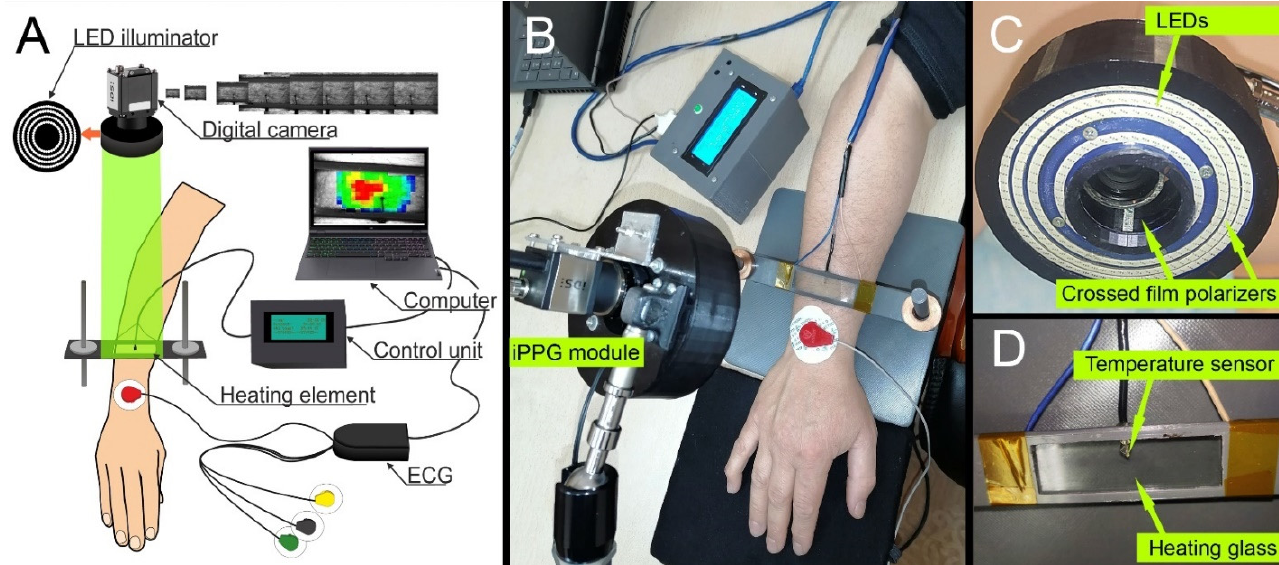
Figure 1. Schematic and photograph of the multimodal system for assessing blood perfusion during the local heating. ( A ) Layout of the multimodal system consisted of three computer-controlled modules (iPPG, heating, and ECG). ( B ) Photograph of the multimodal system. ( C ) IPPG module including digital monochrome camera with the lens. ( D ) Heating element with transparent conductive glass framed in the plastic and built-in temperature sensor.